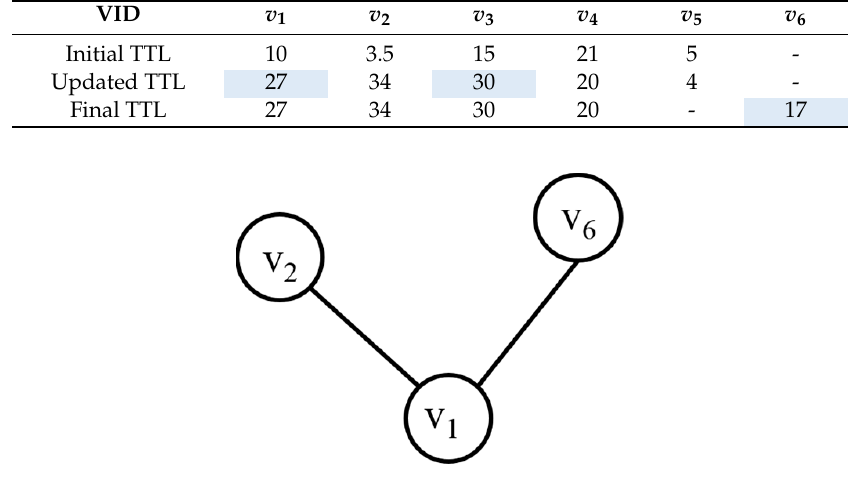
Figure 6. New requested query in UC.